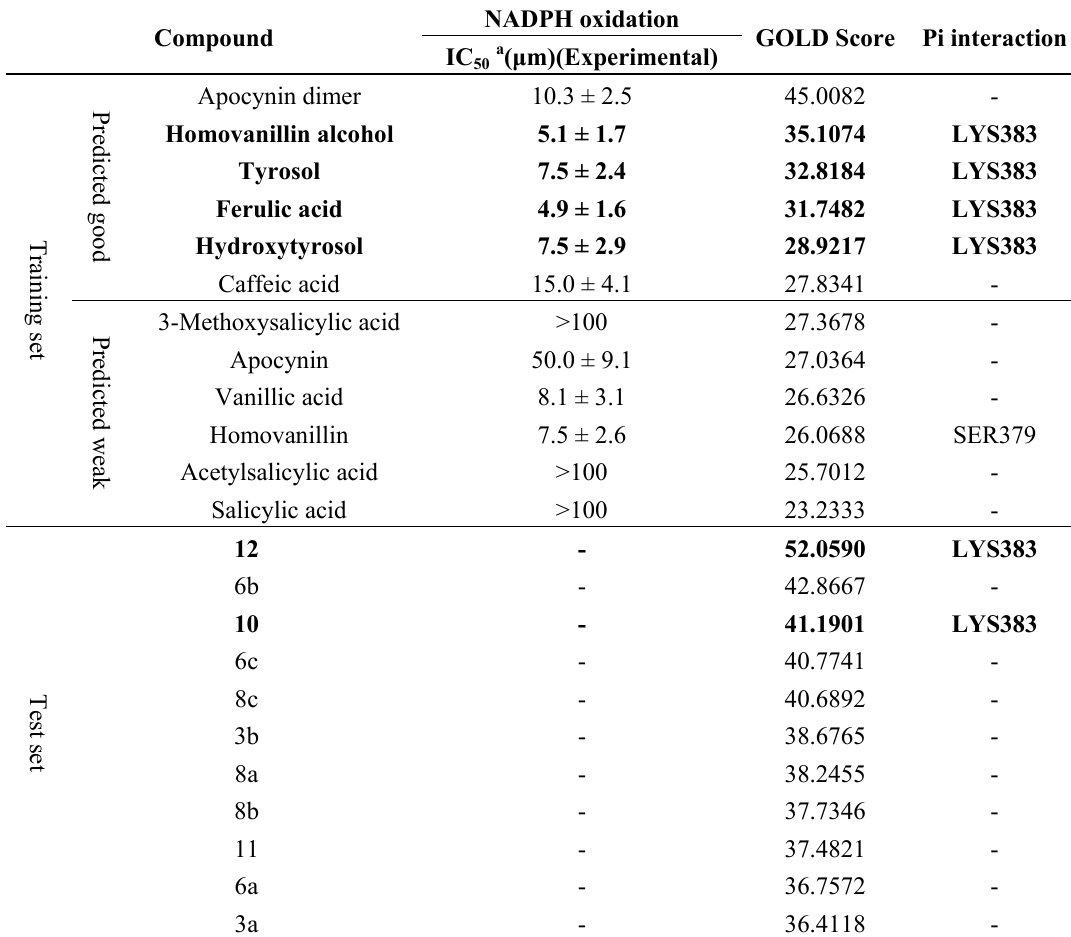
Table 2. Scoring results of the molecular docking training set.